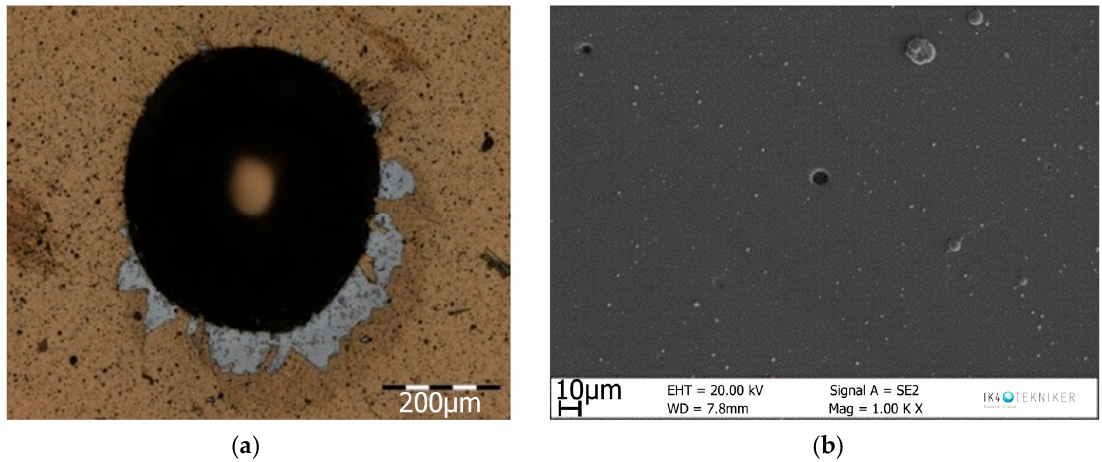
Figure 10. Optical and SEM images for D2 coating; ( a ) adhesion results (optical); ( b ) surface micrograph.